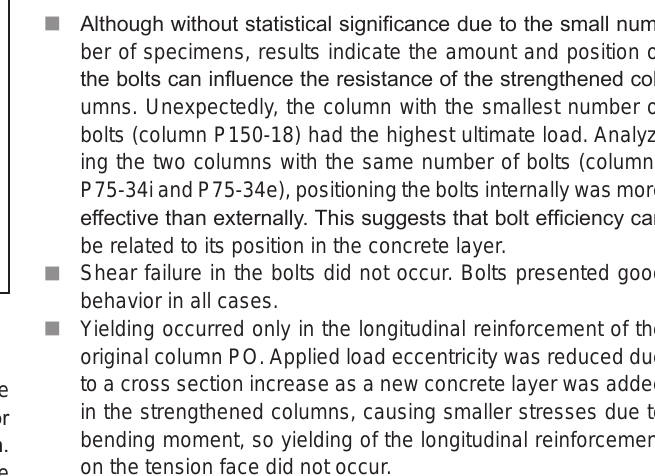
Figure 16 – Photograph of column P75-50 after